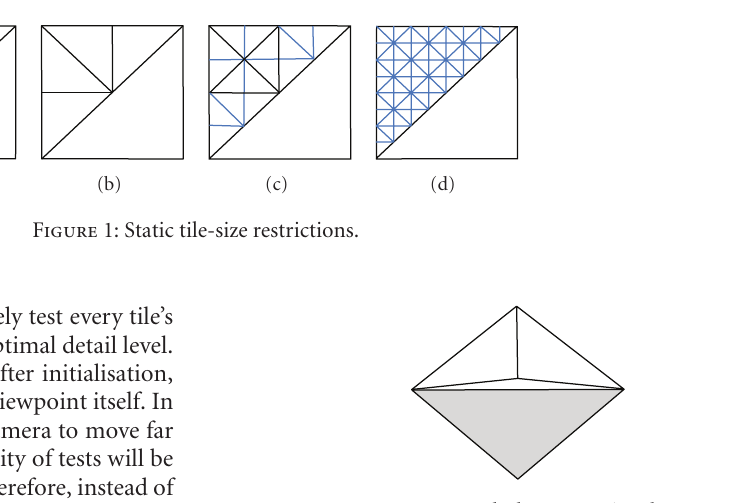
Figure 2: Cracks between